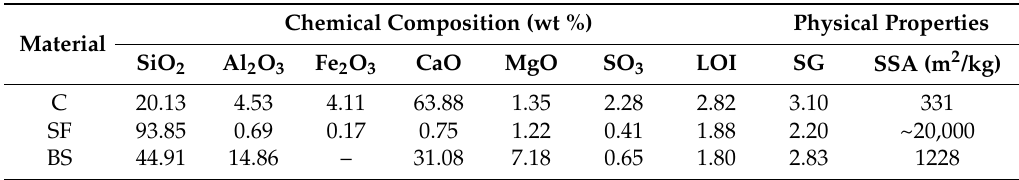
Table 1. Material properties of multi-walled carbon nanotubes (MWCNTs).